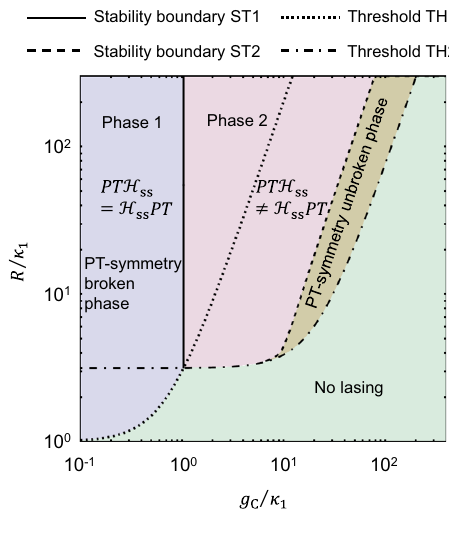
Fig. 4 Phase diagram of the macroscopic-sized open system. The pumping rate R and intercavity coupling strength g C are tuned widely. The loss rate κ 1 of cavity 1 is chosen as the frequency unit in the plot. The whole R (cid:2) g C plane is divided into four regimes by four curves. Two threshold lines (TH1, dotted and TH2, dash-dotted) are determined by two sets of steady-state solutions of the coupled system. Two stability boundary lines (ST1, solid and ST2, dashed) are obtained from the linear stability analysis of the steady-state solutions. In the lasing phase 1, the steady-state Hamiltonian H ss possesses the PT symmetry but the coupled system is in the broken phase. In the lasing phase 2, H is non-PT symmetric. In the ss unstable regime, H t ð Þ becomes PT symmetric and the coupled system is in the unbroken phase. In the rest regime, no lasing action